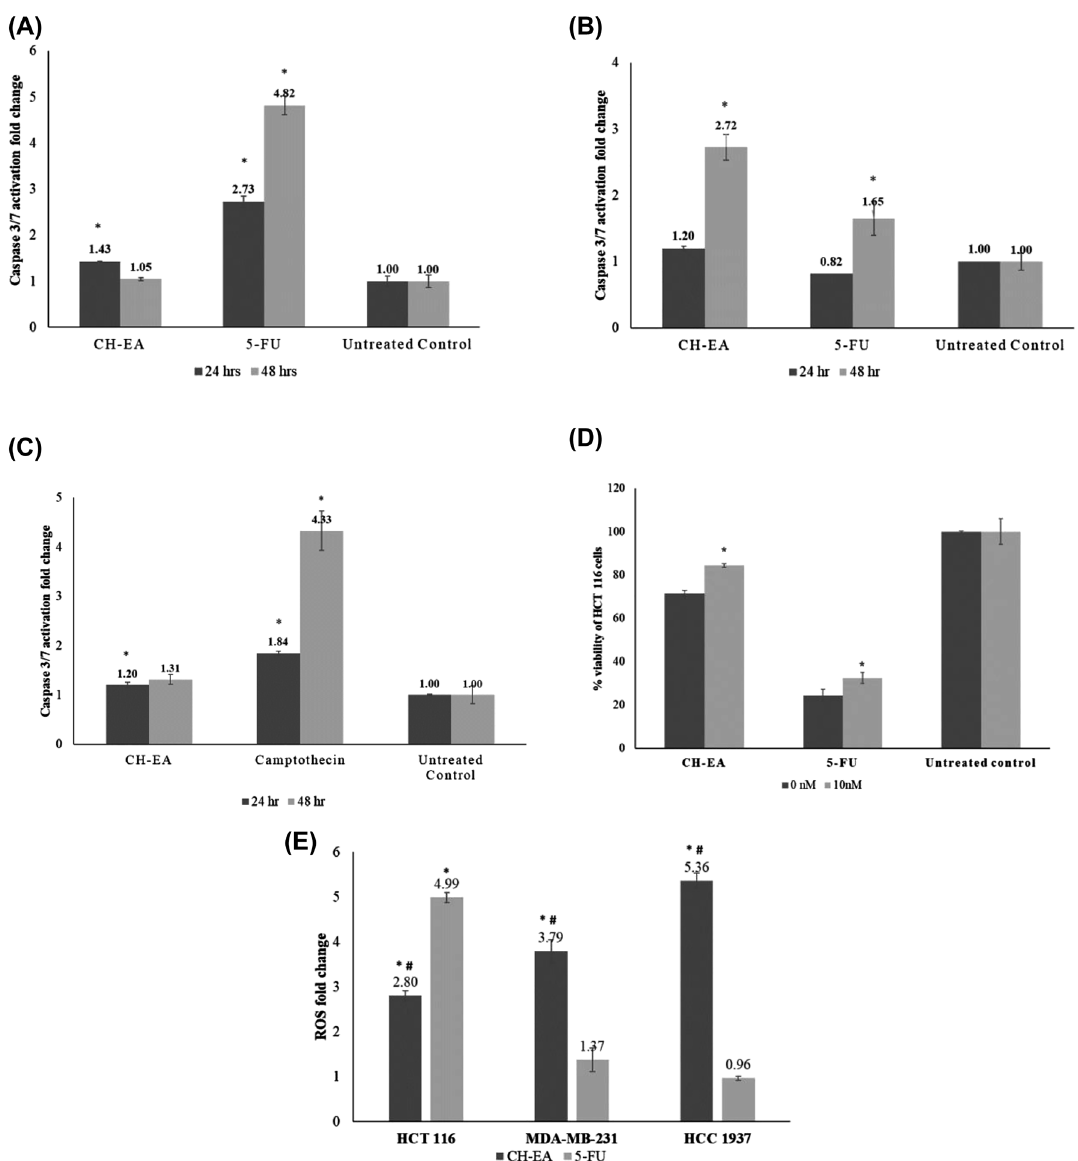
Figure 1: Caspase 3/7 activation in (A) HCT 116 cells (B) MDA-MB 231 and (C) HCC 1937 cells treated with the ethyl acetate extract of C. hystrix (CH-EA) for 24 and 48 h. (D) Percentage viability of HCT 116 cells treated with the ethyl acetate extract of C. hystrix and 10 nM of pan-caspase inhibitor zVAD.fmk for 24 h and (E) ROS determination in HCT 116, MDA-MB 231 and HCC 1937 cells treated with the ethyl acetate extract of C. hystrix (CH-EA) for 90 min. *Indicates values signi fi cantly different compared to untreated control (p<0.05). #Indicates values signi fi cantly different compared to 5-FU